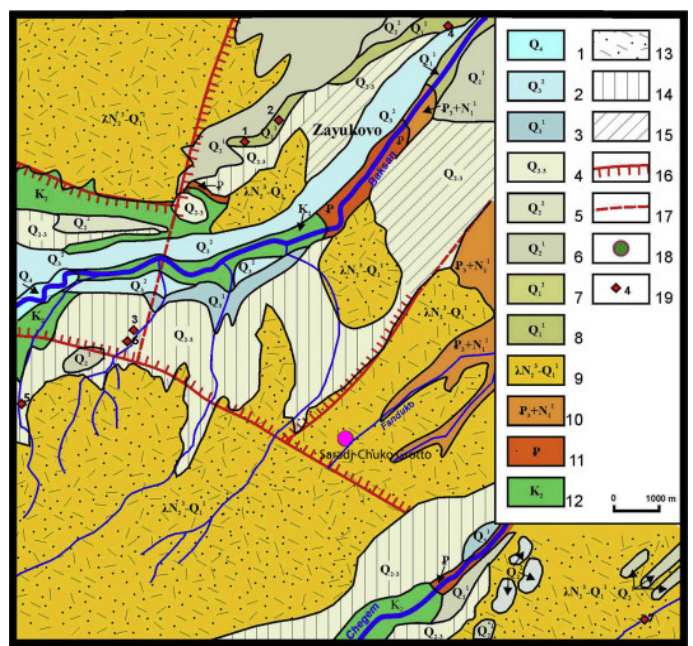
Figure 3. The Geology near Saradj-Chuko Grotto. Saradj-Chuko Grotto lies within the Lower Chegem Formation, which erupted in the extension zone between the Laba-Malka monoclinal uplift and the Tarak-Caspian Trough, during the collision zone between southern Euroasia and the Arabian Plate during the latest Pliocene and earliest Pleistocene (Gelasian). These volcaniclastic deposits extensively occur in the area. Zayukovo (Baksan) obsidian (Obsidian sites 1 and 2) was found in Layer 6B. Legend: 1–8: Quaternary units; 9: Early Gelasian-Late Pliocene Lower Chegem Fm.; 10: Middle-Upper Oligocene to Lower-Middle Miocene, Maikop Fm.; 11: Paleogene strata; 12: Upper Cretaceous strata; 13: Acidic volcanogenic deposits, mainly tuffs; 14: Undissected landslide, scree, deltaic, and fluvial units; 15: Fluvial deposits; 16: Emergent discharge, 17: Buried discharge; 18: Saradj-Chuko Grotto; 19: Obsidian and flint outcrops: 1–4: All Zayukovo (Baksan) obsidian; 5: Shtauchukua-1 flint; 6: HanaHaku-1 flint; 7: Kamenka-1 flint (adapted from Kizevalter and Karpinsky [20]).